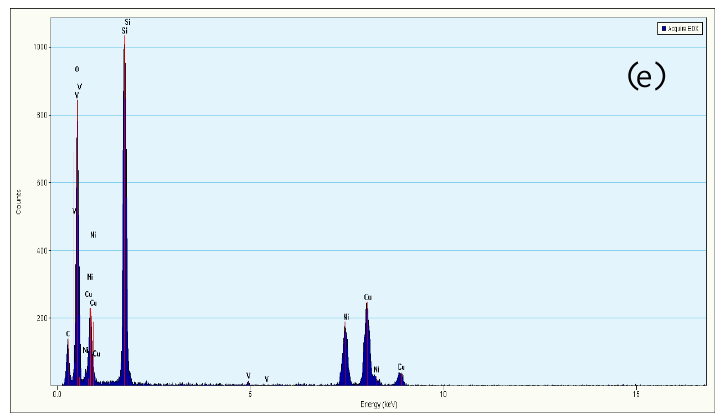
Figure 4. TEM images of ( a ) KIT-6; ( b ) 10Ni / KIT-6; ( c ) 10Ni-0.5V / KIT-6; ( d ) 20Ni-0.5V / KIT-6; ( e ) energy-dispersive X-ray spectroscopy (EDX) spectrum of 20Ni-0.5V / KIT-6.